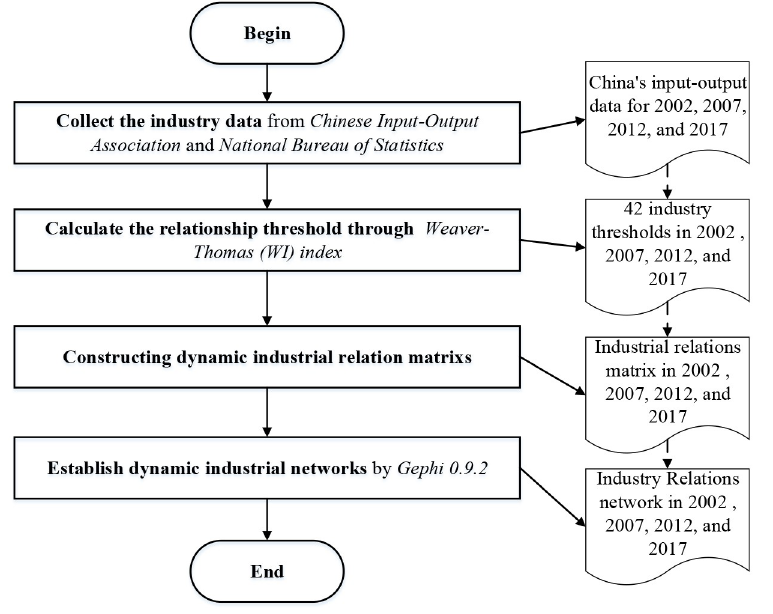
Fig 2. The procedure of data collection and